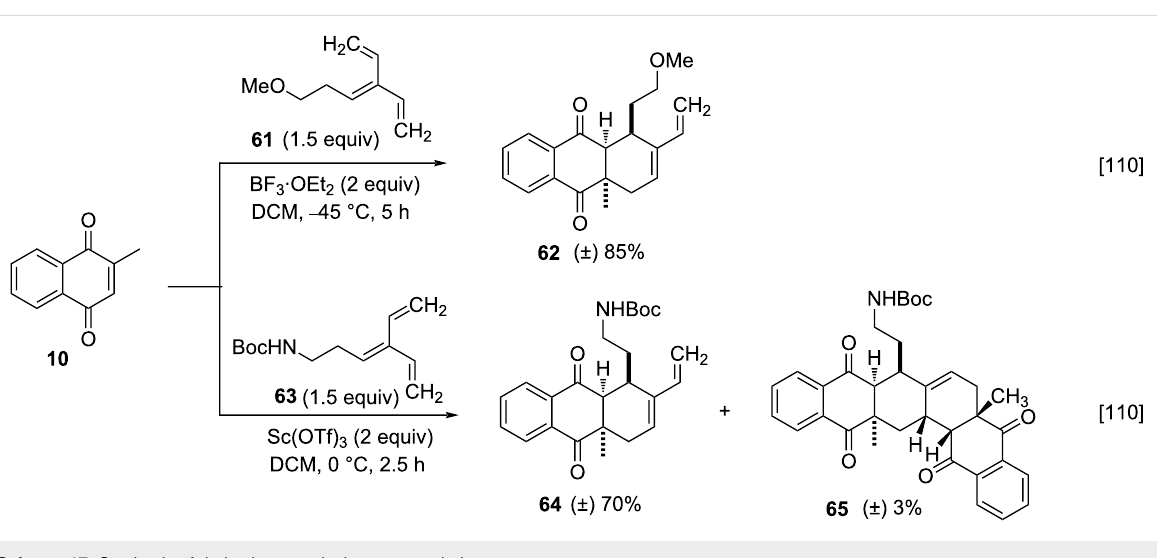
Scheme 17: Synthesis of derivatives employing protected